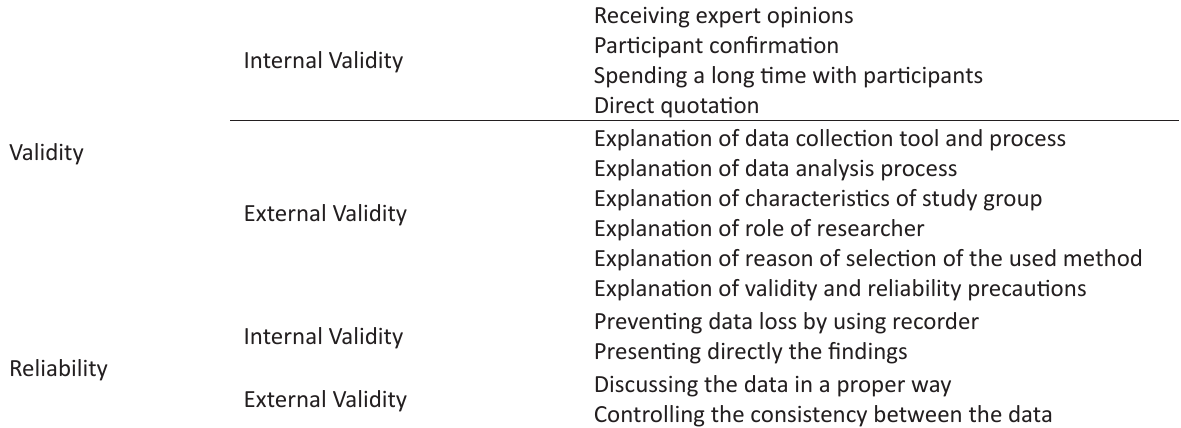
Table 1. Validity and reliability criteria towards qualitative research